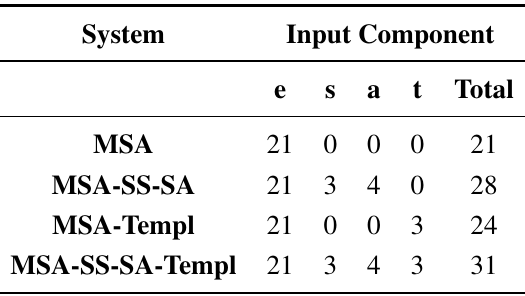
Table 4. The number of inputs per component for a given residue in each of the six systems. SS, secondary structure; SA, solvent accessibility; Templ,